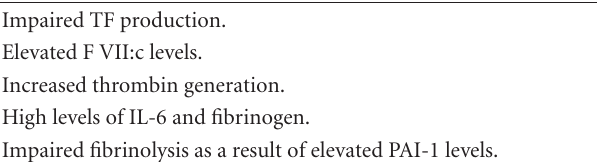
Table 2: Coagulation and Fibrinolysis Dysregulation in Diabetes Mellitus.